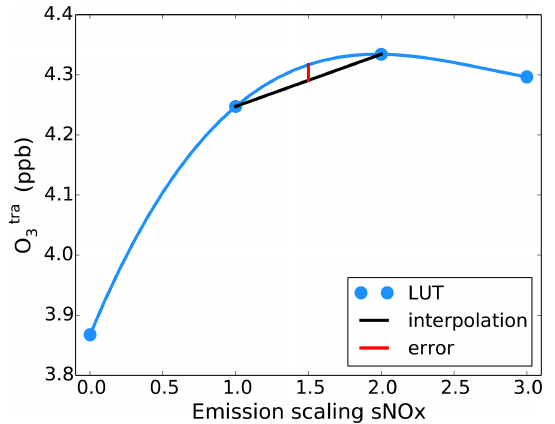
Figure 3. Schematic of the interpolation error caused by the linear interpolation in the